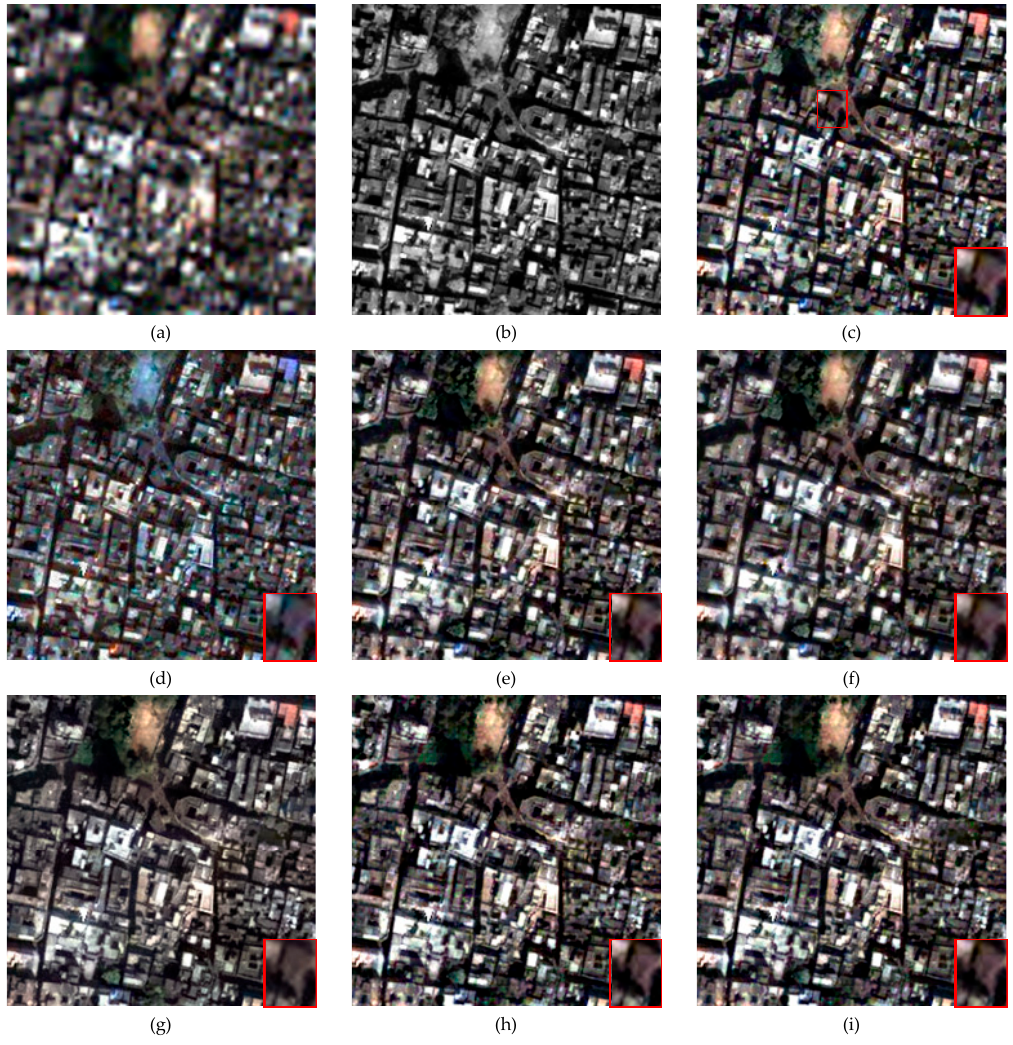
Figure 11. Fusion results of full-scale QuickBird images. ( a ) LR MS image, ( b ) PAN image, ( c ) GIHS [49], ( d ) PCA [6], ( e ) AWLP [50], ( f ) SVT [12], ( g ) SparseFI [32], ( h ) NE, ( i ) SWNE. Table 3. Numerical results of each fused image shown in Figure 1.